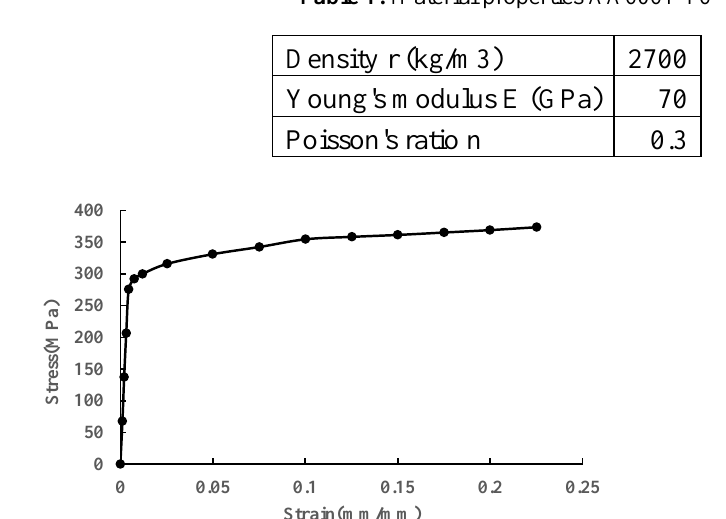
Table 1: Material properties AA6061-T6